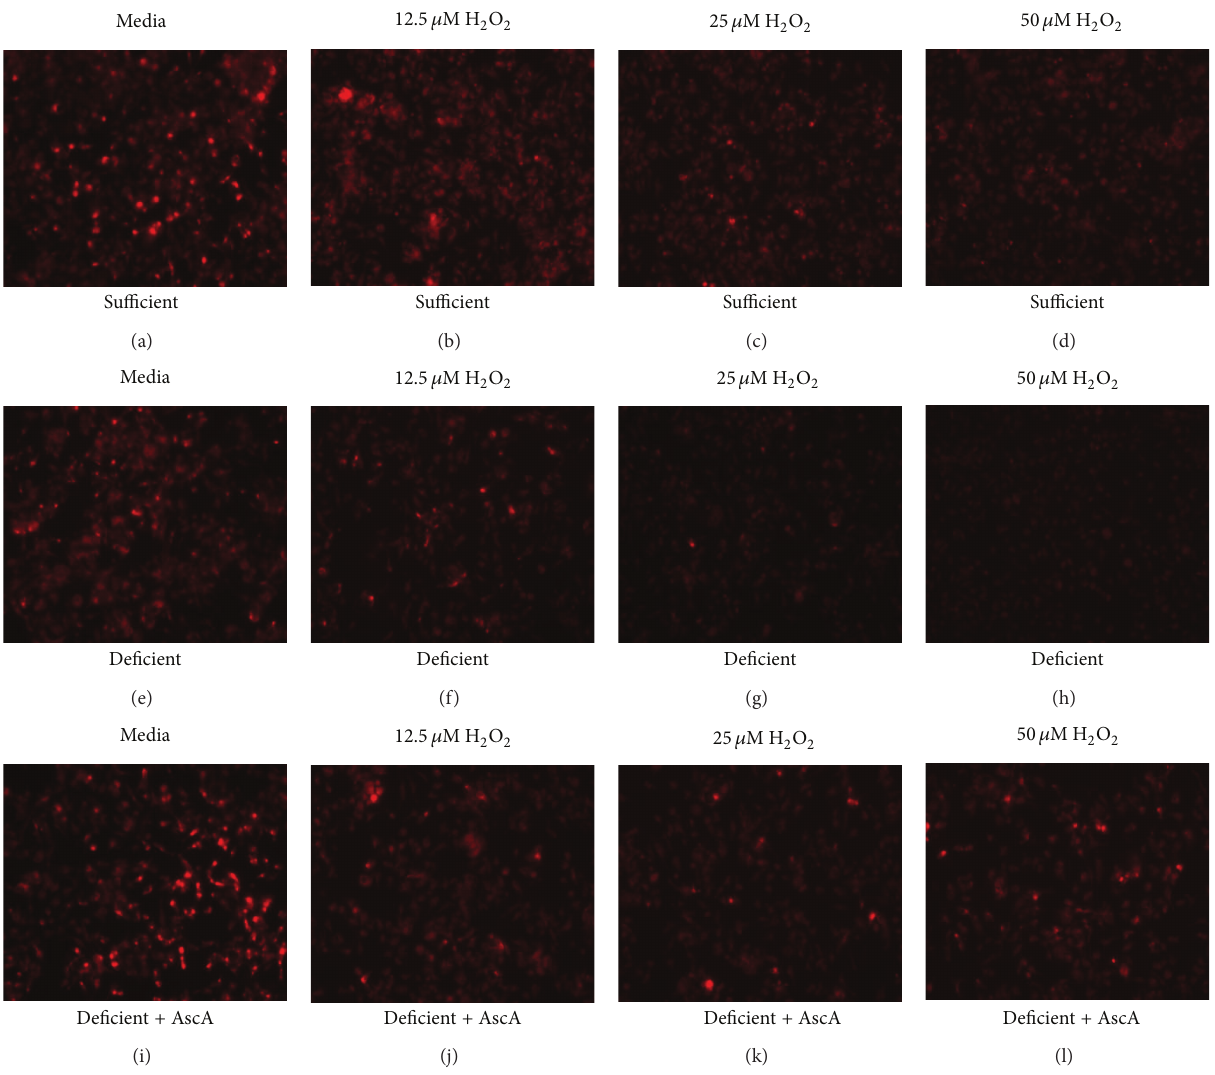
Figure 6: Macrophages deficient in Vitamin C have reduced antioxidant capacity. Peritoneal macrophages elicited on day 3 following TG- induced peritonitis from VitC sufficient ((a)–(d)) and deficient Gulo −/− ((e)–(h)) mice were exposed to 12.5, 25, and 50 𝜇 M H 2 O 2 for 18 hours and probed with MitoTracker Red CMXRos. Macrophages from some VitC deficient mice were incubated with AscA (3mM, 16 hours) prior to exposure to H 2 O 2 followed by staining with MitoTracker Red CMXRos (Deficient + AscA,